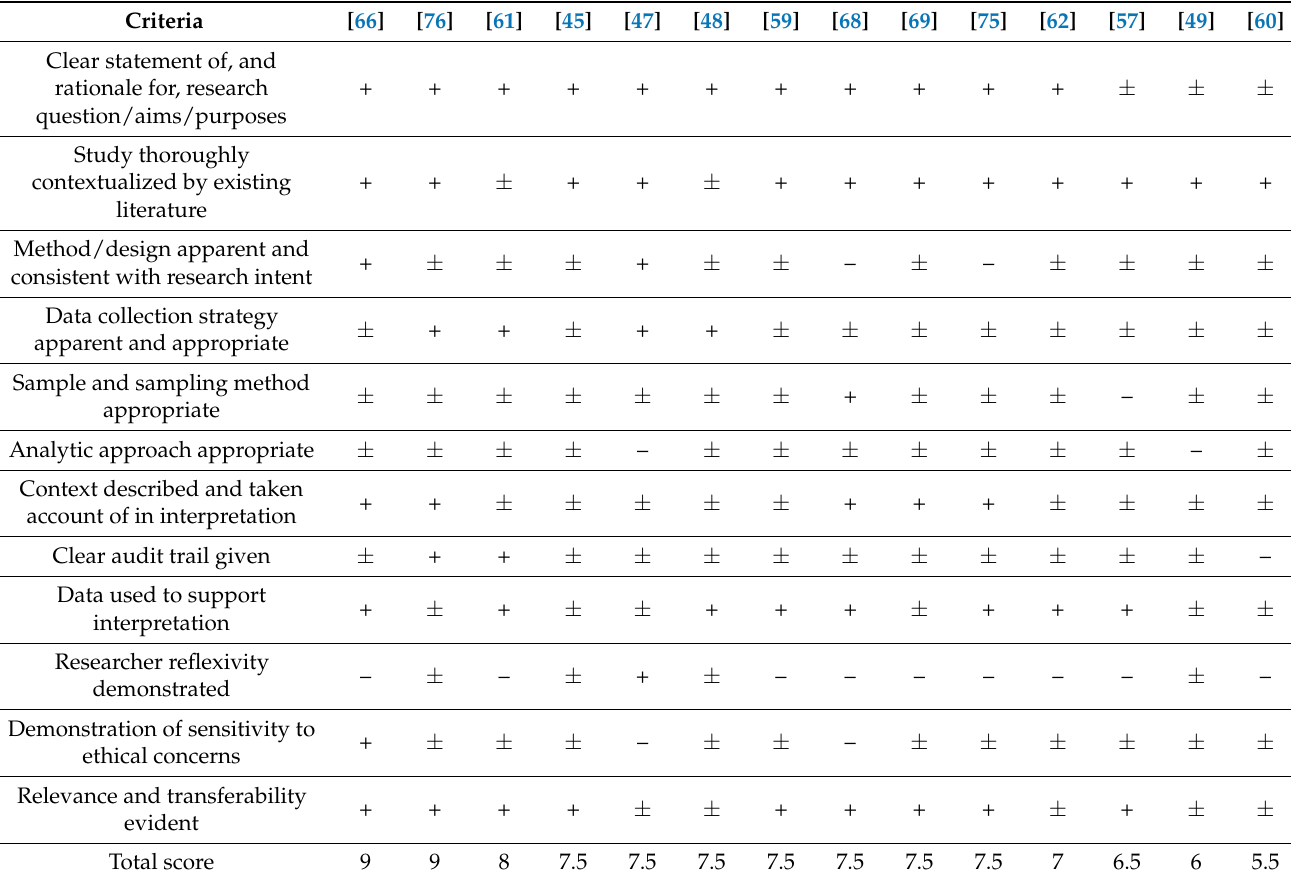
Table 3. Quality appraisal of qualitative studies (Walsh and Downe criteria) ( n = 14 )